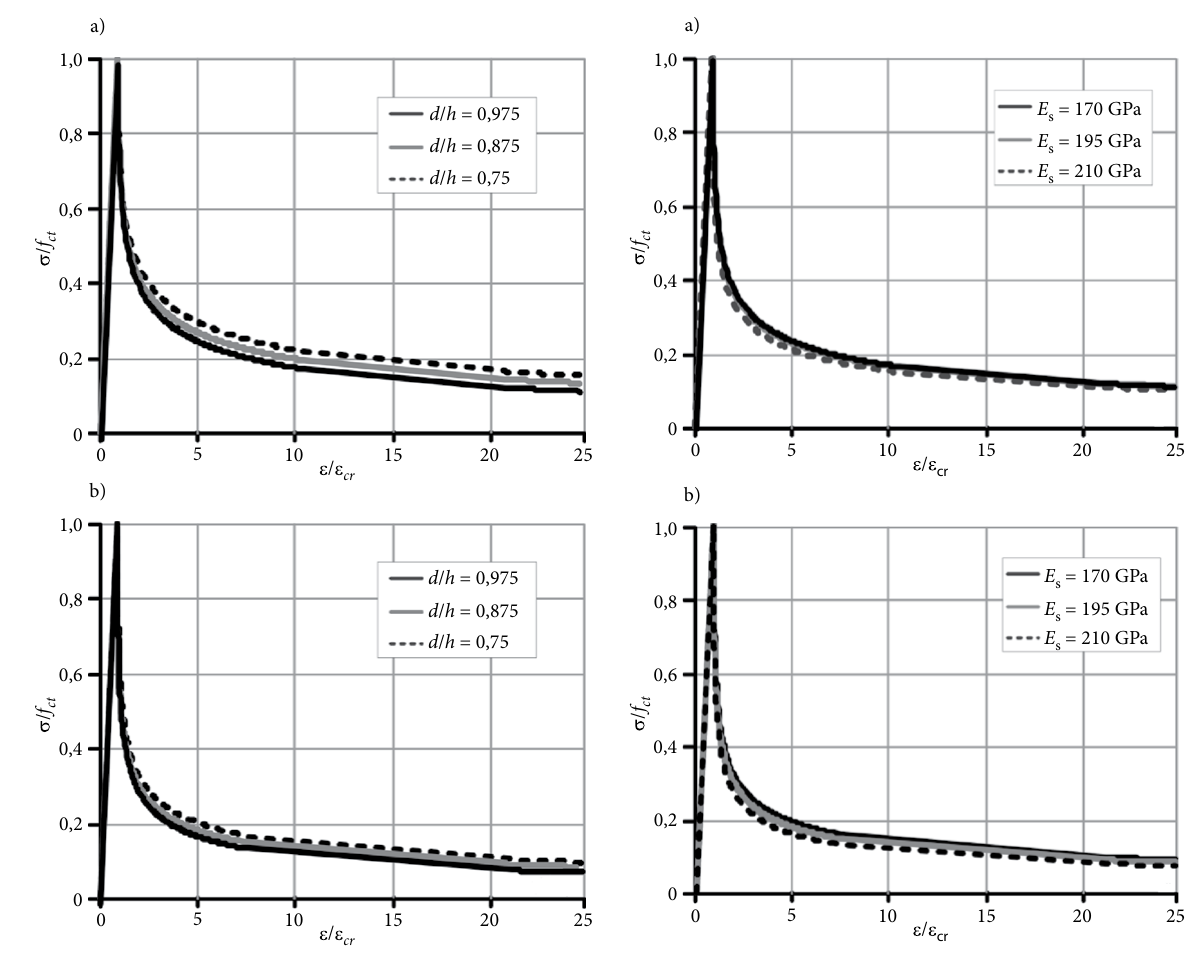
diagramos, kintant naudingajam skerspjūvio aukščiui: a - r = 1,0 %; b - r = 2,0 % Fig. 7. Numerically derived tension stiffening diagrams of varying normalised effective depth: a - r = 1,0 %; b - r = 2,0 %